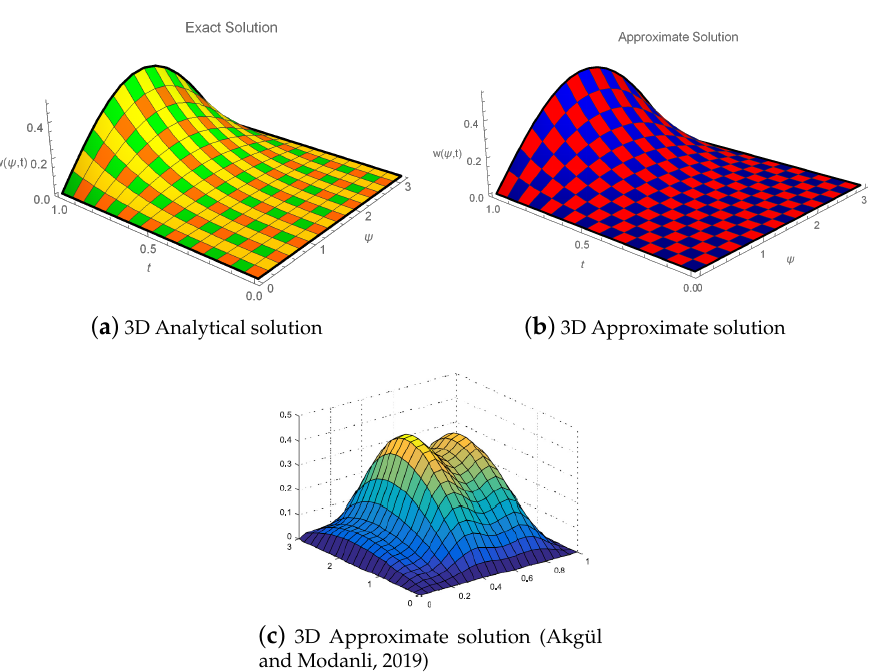
Figure 5. Comparison between 3D analytical, proposed approximate, and approximate [10] solutions of example 1 for γ = 0.81 and ˜ M = K =